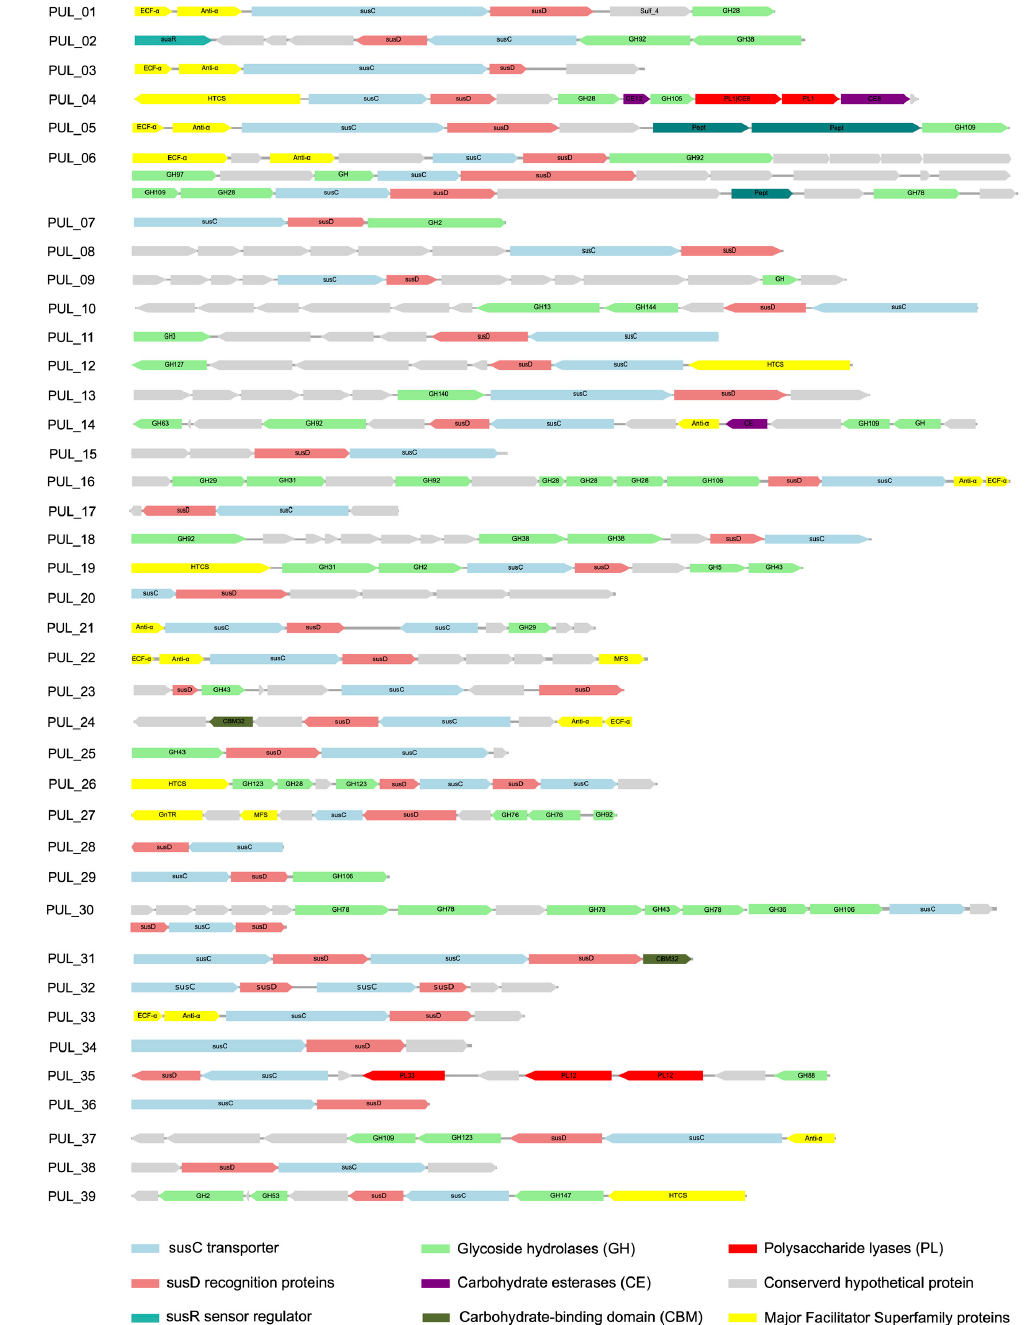
Figure 4. Schematic overview of PUL (Polysaccharide Utilization Loci) predicted in the P. mucosa ING2-E5A T